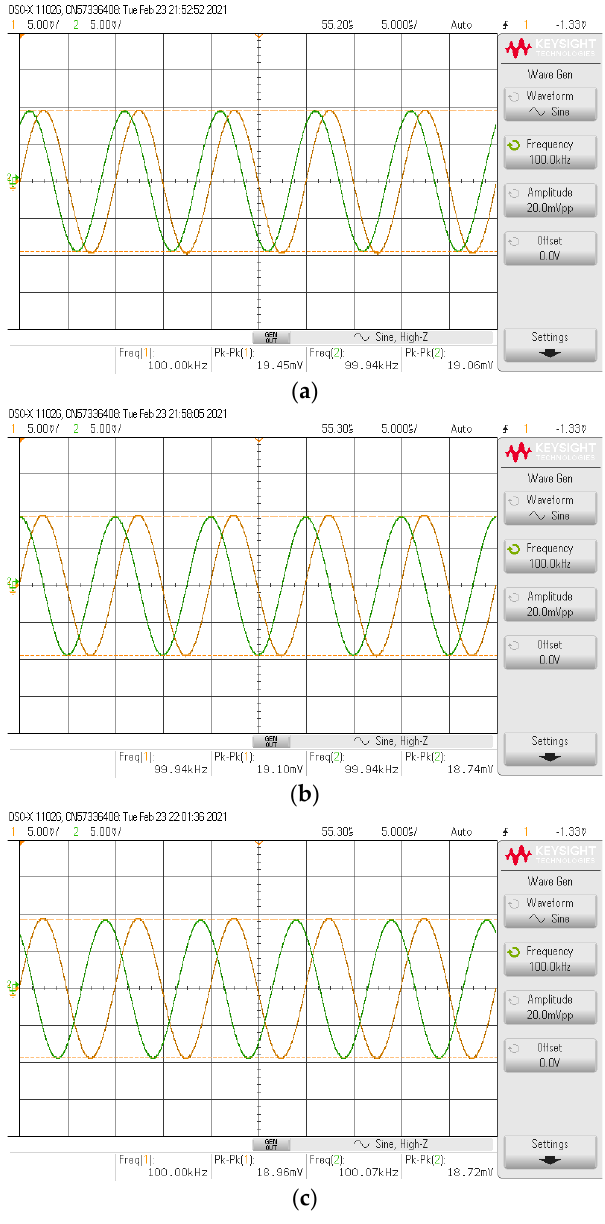
Figure 17. Measured input and output waveform of AP+ ( ‐‐‐‐ v in , ‐‐‐‐‐ v o ). ( a ) I B = 67 μ A. ( b ) I B = 124.5 μ A. ( c ) I B = 245 μ A.